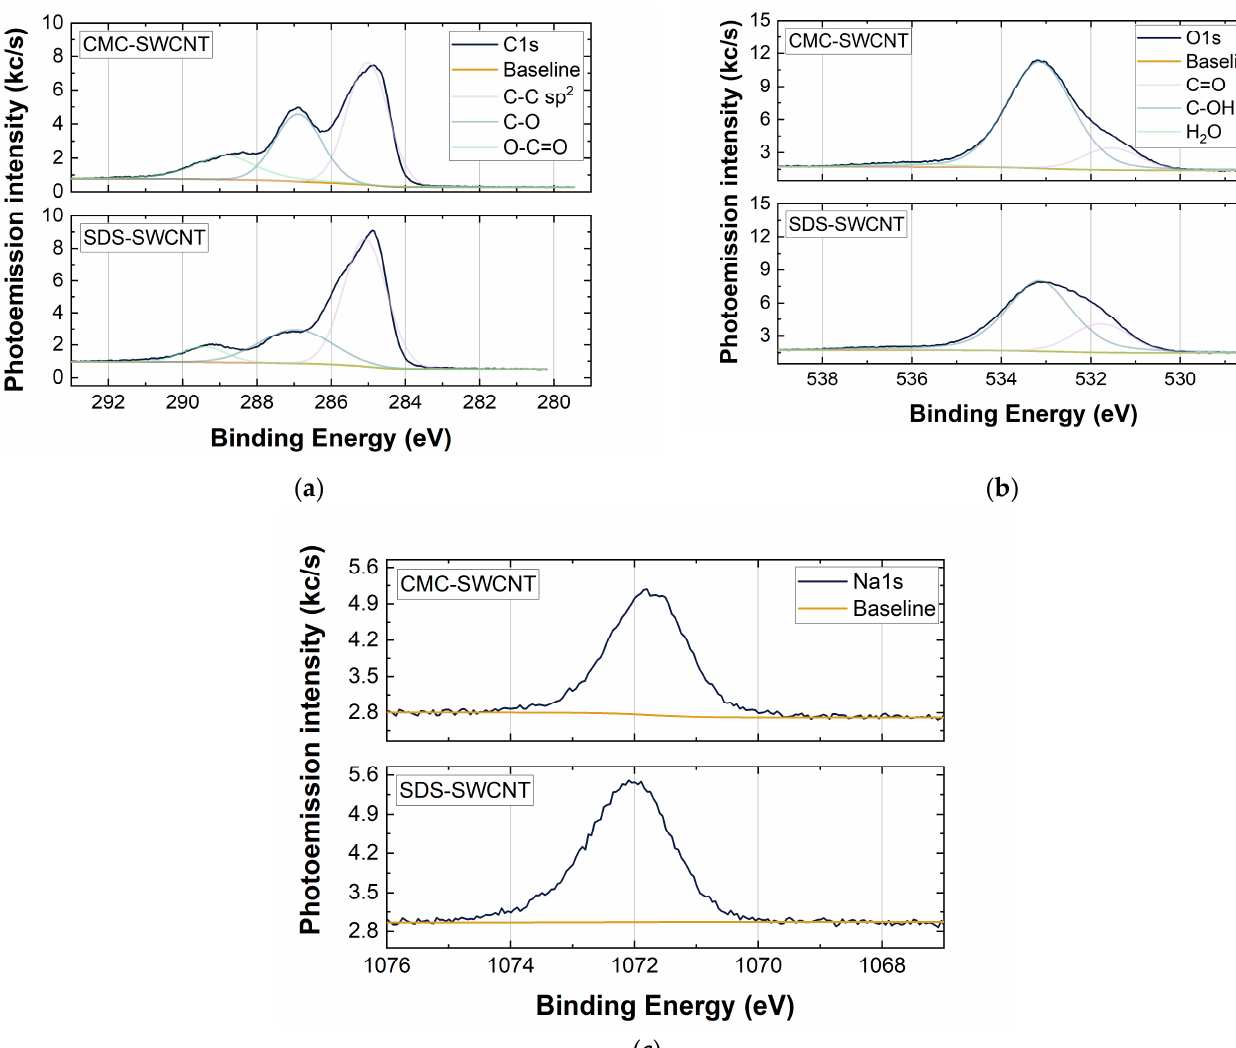
Figure 6. XPS analysis in high-resolution scan that shows the elemental composition of the samples. The analyses refer to ( a ) C 1s, ( b ) O 1s, and ( c ) Na 1s core levels for the CMC-SWCNT (150 layers) and SDS-SWCNT (150 layers)